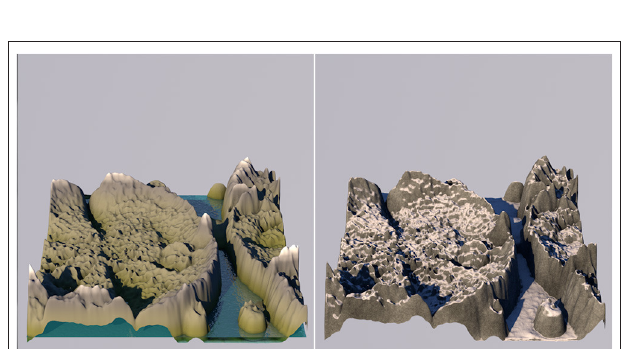
FIGURE 6 | Grayscale 512 × 512-pixel section of microbial scan after light blurring (original shown in Figure 5 ) with a low-width blurring filter (Left) . Shape of the corresponding terrain, showing strongly reduced terrain noise (Right) .